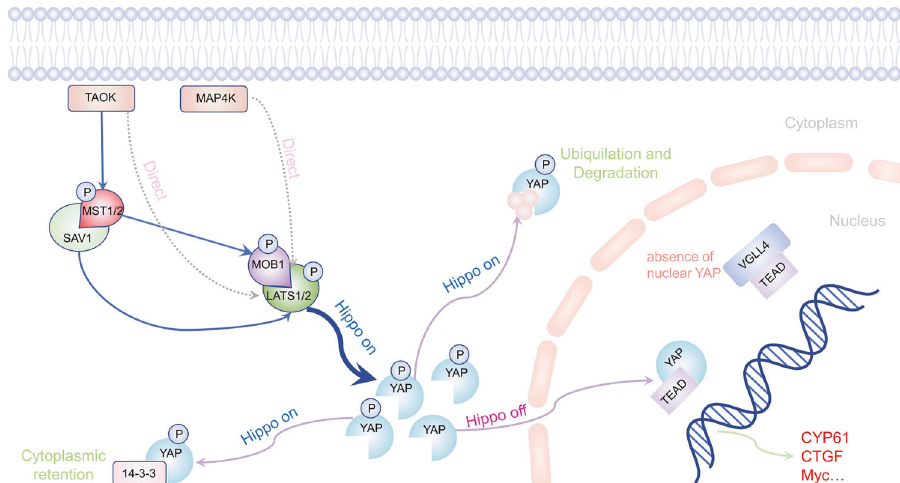
Fig. 1 Hippo signaling pathway. The hippo pathway is mainly composed of MST1/2, LATS1/2, SAV1, MOB1, YAP or TAZ, and TEAD. When the hippo pathway is unactivated, unphosphorylated YAP enters the nucleus and binds to TEAD, thus inducing transcription of target genes. When the hippo pathway is activated, TAOK phosphorylates MST1/2. Phosphorylated MST1/2 binds to SAV1 to form the MST1/2-SAV1 complex. With the assistance of activated MOB1, the MST1/2-SAV1 complex induces phosphorylation of the LATS1/2. Phosphorylated LATS1/2 activates YAP, resulting in YAP being captured by 14-3-3 proteins in the cytoplasm or being degraded by SCF β -TRCP E3 ubiquitin ligase mediated ubiquitin-proteasome pathway. Note: TAOK, thousand-and-one amino-acid kinase; MAP4K1-7 mitogen-activated protein kinase kinase kinase kinases 1 – 7, MST1/2 mammalian STE20-like kinase 1/2, SAV1 sav family containing protein 1, LATS1/2 large tumor suppressor 1/ 2, MOB1 MOB kinase Activator 1, TEA TEA domain family, VGLL4 vestigial-like family member